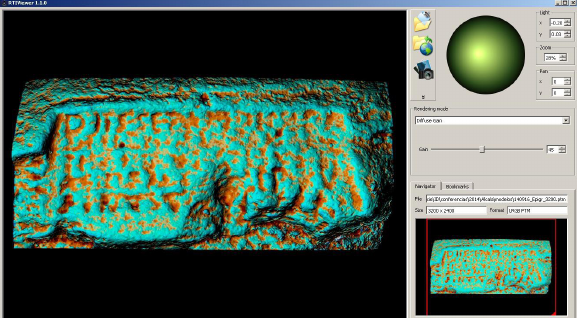
Figure 6: The final result of the proposed methodology: a V- PTM built from a MRM colour-coded 3D model of an inscription from Panóias